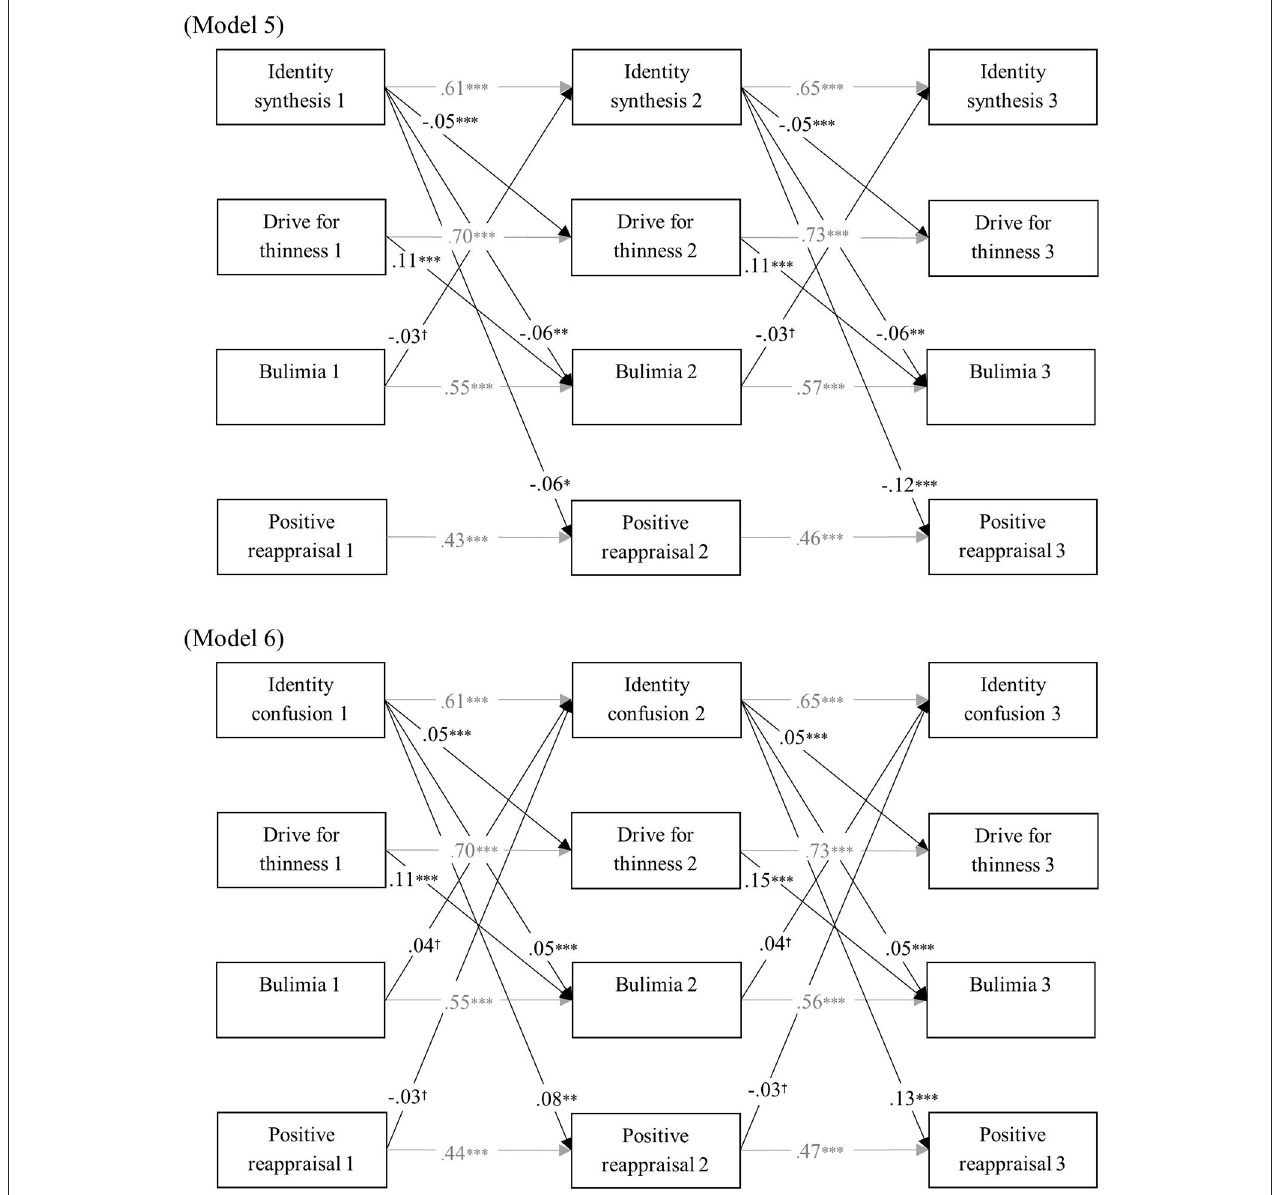
FIGURE 4 | Final cross-lagged models linking identity functioning, ED symptomatology, and positive reappraisal. All models were controlled for age and gender. Within-time associations, associations with age and gender, and insignificant cross-lagged paths were not shown for reasons of clarity. All path coefficients are standardized. † p < 0.05, ** p < 0.01, *** p <